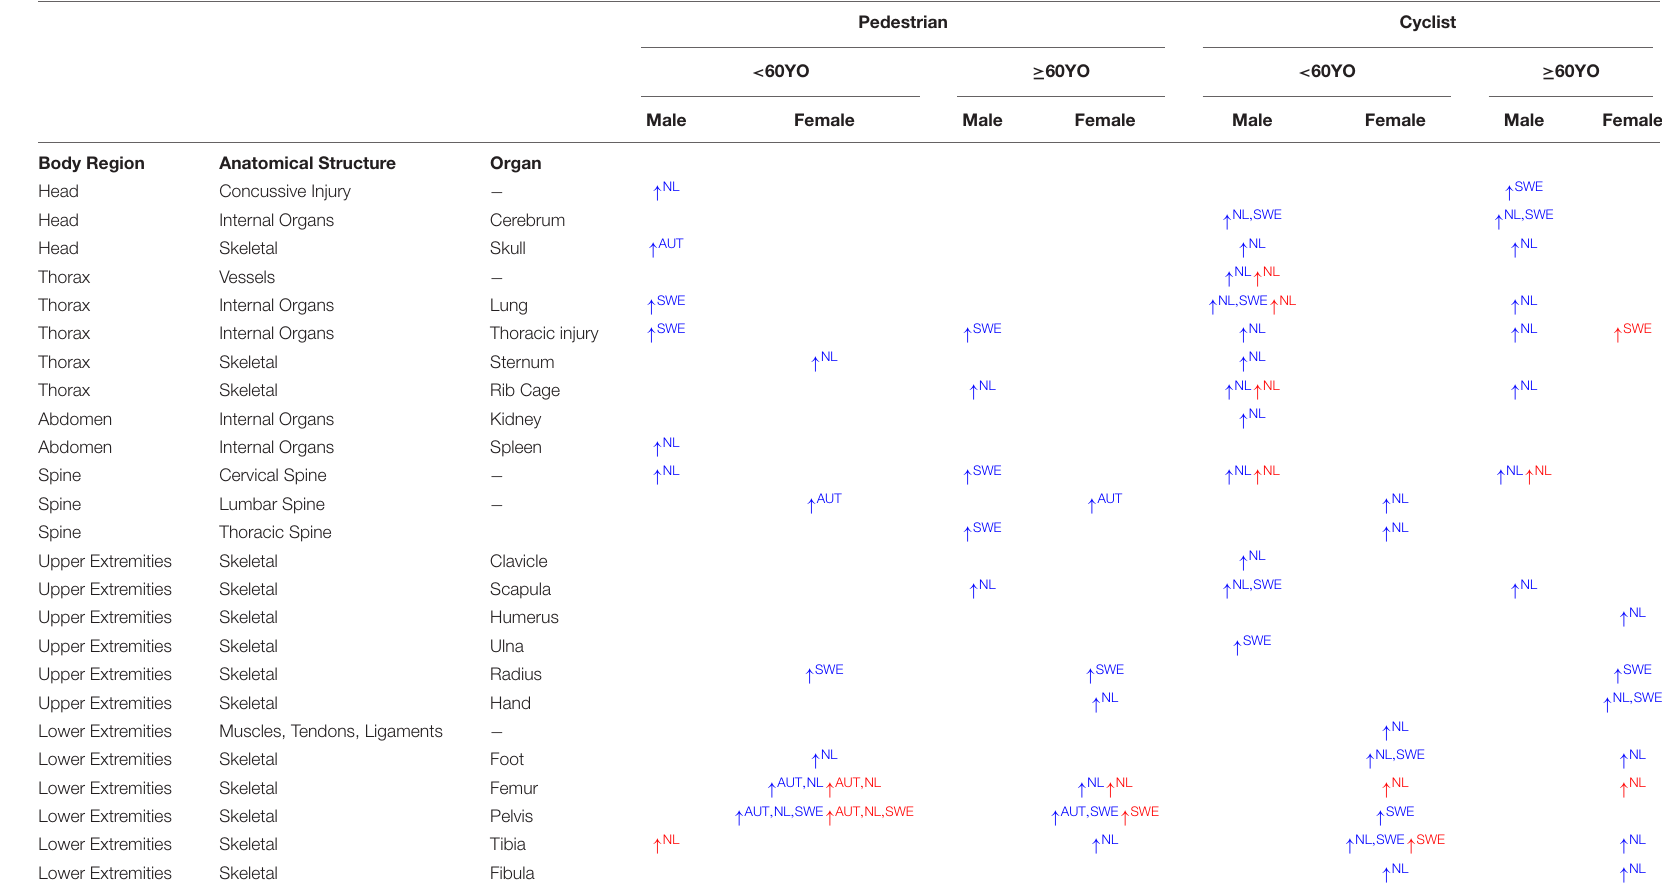
TABLE 12 | Summary of all single injuries with significant differences for pedestrians and cyclists for Austria (AUT), Netherlands (NL), and Sweden (SWE). Pedestrian Cyclist